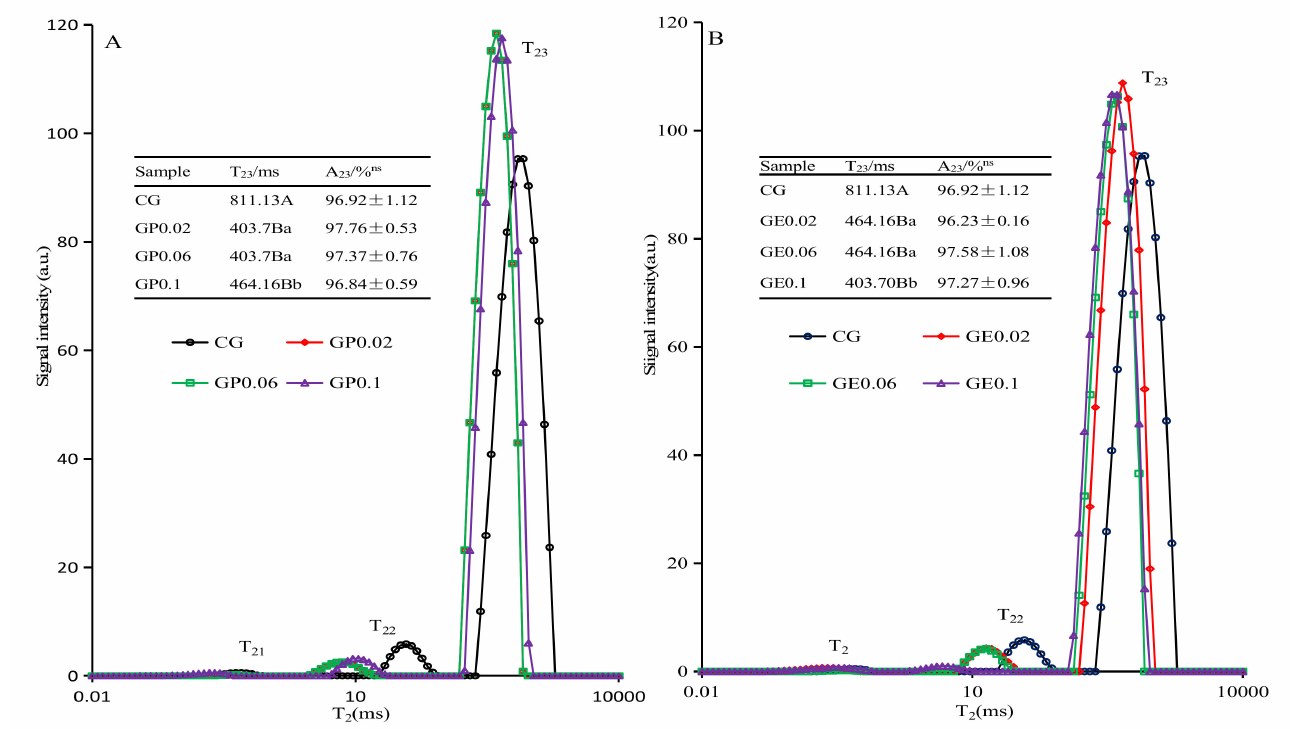
Figure 2. Distribution of T2 relaxation times estimated by distributed exponential fitting of LF-NMR on yoghurts with different GP ( A ) and GE ( B ) concentrations. T 21 , transverse relaxation time of bound water; T 22 , transverse relaxation time of semi-bound water; T 23 , transverse relaxation time of mobile water; A 23 , area mobile water. Different capital and small superscript letters in the same column indicate significant differences between and within groups respectively ( p ≤ 0.05). ns, not significantly different ( p >